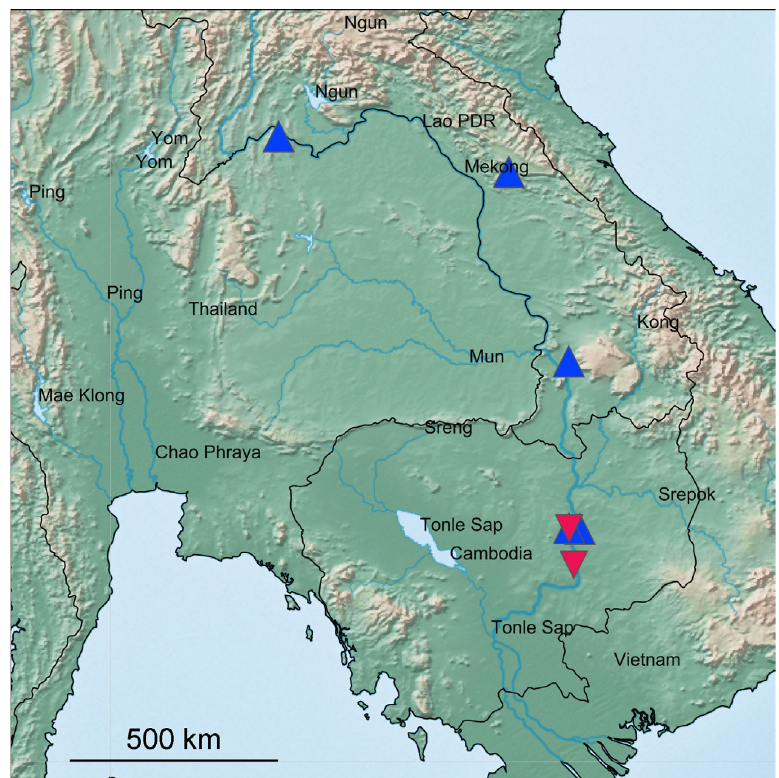
Fig. 11. Distribution of Cambonilla securicula Jocqué gen. et sp. nov. (▲) and Cambonilla symphonia Jocqué & Henrard gen. et sp. nov.